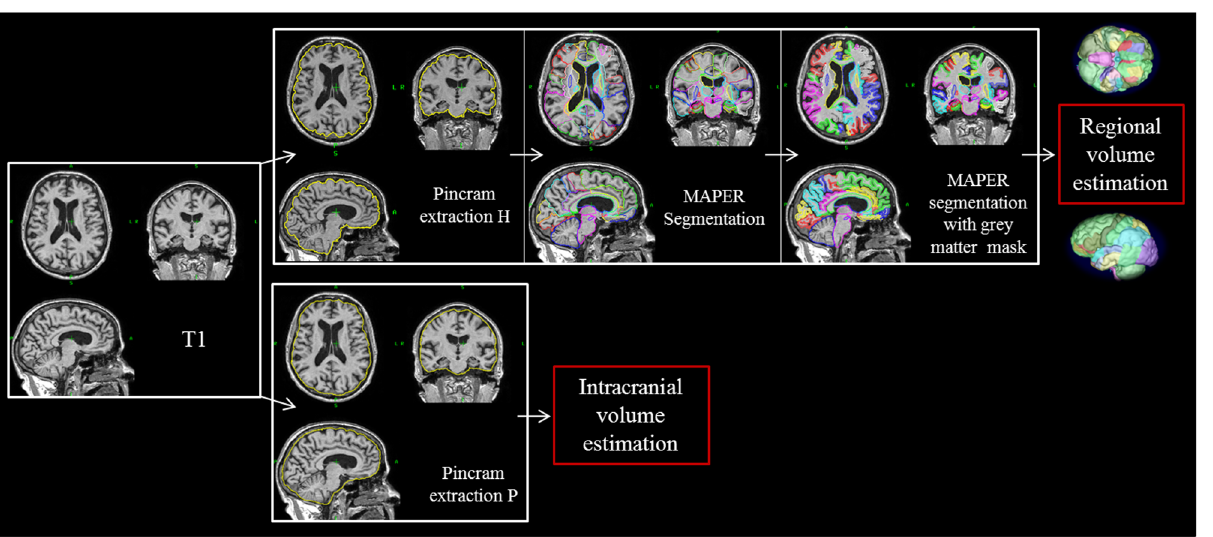
Fig 1. Pincram brain extraction and MAPER segmentation. MRI T1 sequences were processed with pincram, followed by MAPER and grey matter masking to obtain regional grey matter volumes. Extraction P was used to estimate the intracranial volume. Pincram extraction H : Brain extraction using the Hammers atlases; Pincram extraction P : Brain extraction using the PACO-customized